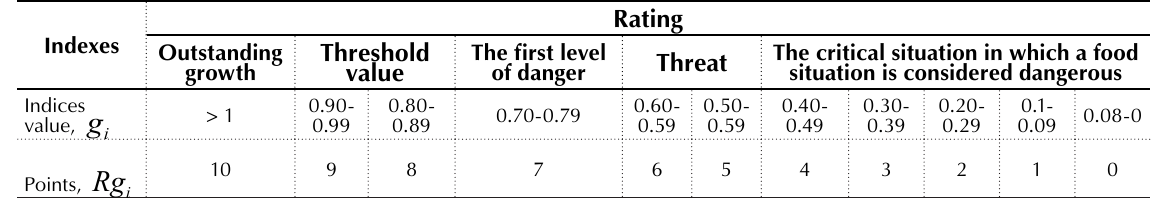
Source: Adapted by the